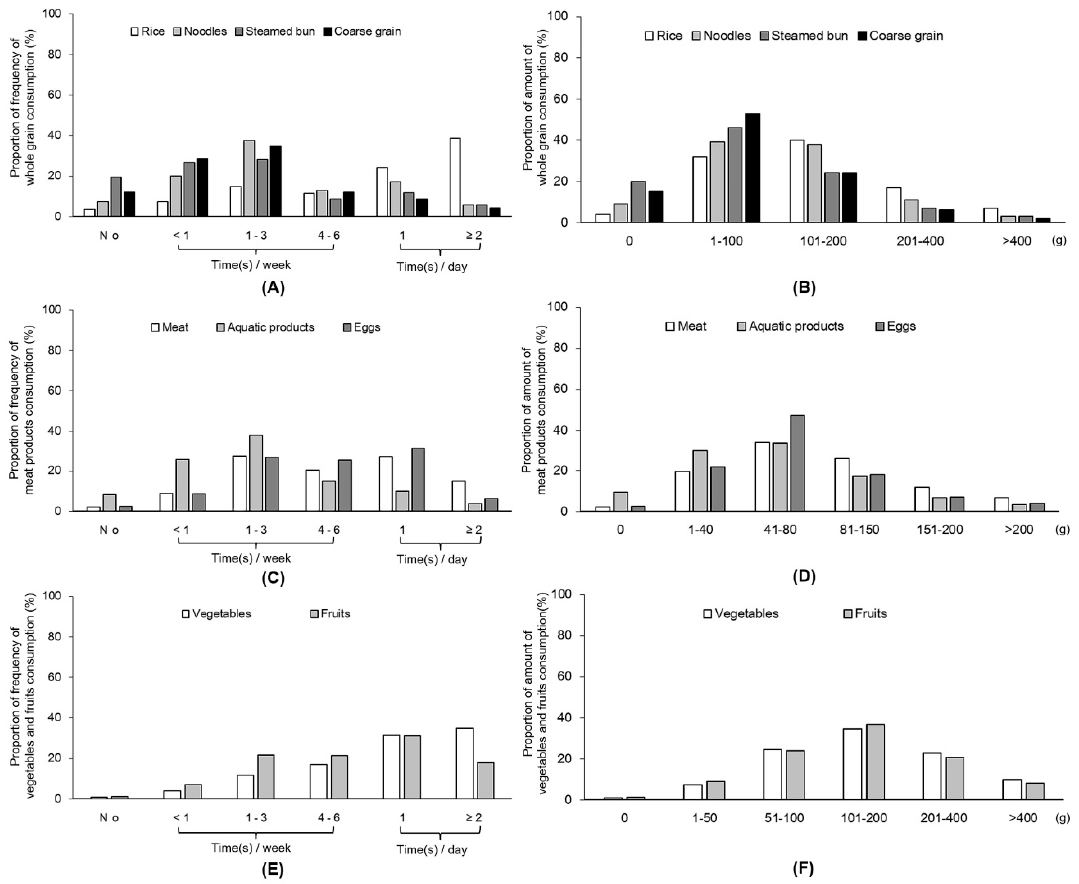
Figure 3. Proportion of dietary consumption frequency and daily amount during the home-isolation period. ( A ) Consumption frequency of whole grain. ( B ) Daily amount consumption of whole grain ( C ) Consumption frequency of meat products. ( D ) Daily amount consumption of meat products. ( E ) Consumption frequency of vegetable and fruit. ( F ) Daily amount consumption of vegetable and fruit.